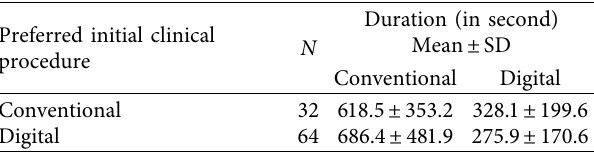
Table 3: Relationship between preferred technique and procedure duration. Preferred initial